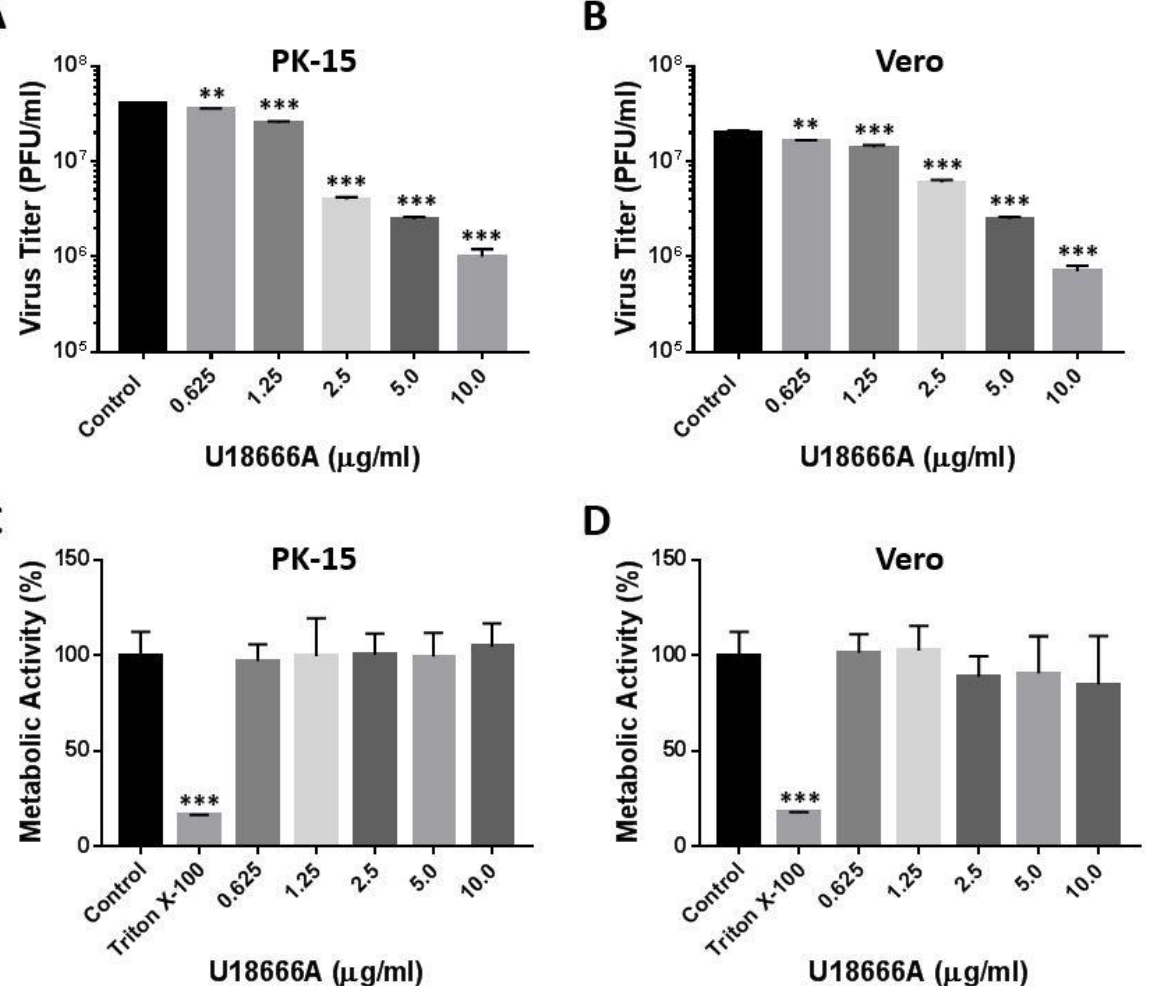
Figure 2. U18666A inhibits production of infectious PRV particles. PK-15 ( A ) or Vero ( B ) cells were infected with PRV at an MOI of 5 in the presence of U18666A (0.625 – 10 μg /mL) or DMSO (0.1%, v / v ) as a control. At 48 h post-infection, virus titer in the culture supernatant was measured by plaque assay. Virus titer is presented in plaque-forming units (PFU)/mL. Data are mean ± SD ( n = 3). ** p < 0.01; *** p < 0.001. Metabolic activity of PK-15 ( C ) or Vero ( D ) cells was measured 48 h after U18666A treatment using the Cell Titer 96 Aqueous One Solution Cell Proliferation Assay (Promega). DMSO (0.1%, v / v ) and Triton X-100 (0.1%, v / v ) were included as negative and positive controls for cell cytotoxicity. The level of metabolic activity was normalized to the DMSO-treated control (100%). Data are mean ± SD ( n = 3). *** p < 0.001.